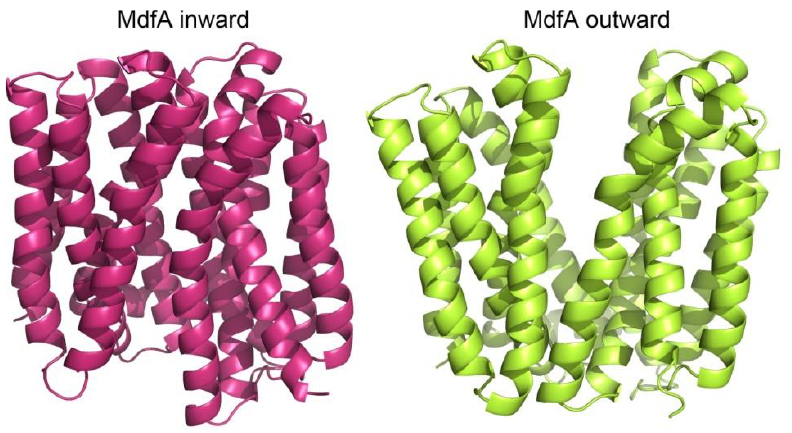
Figure 1. Inward (4zp0) and outward (6gv1) conformations of MdfA. Structures were visualized in Pymol.